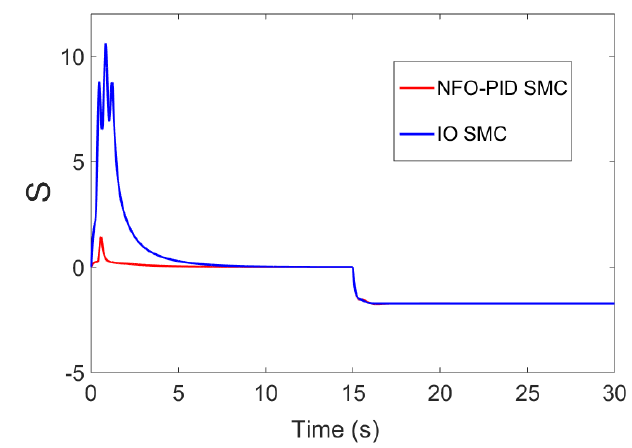
Figure 5. Curves of second-layer sliding mode surfaces S. Appl. Sci. 2020 , 10 , x FOR PEER REVIEW